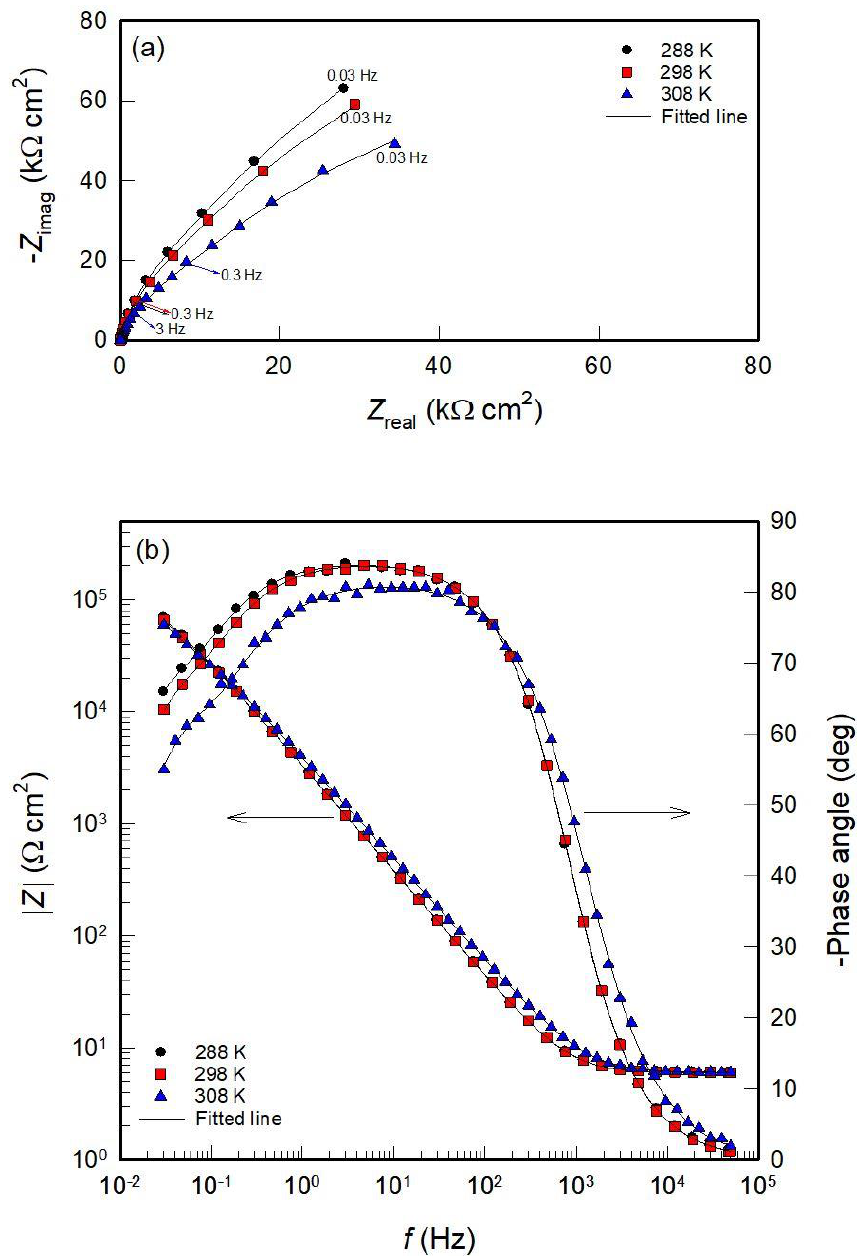
Figure 2. ( a ) Nyquist and ( b ) Bode diagrams for AISI 316L in seawater at different temperatures.